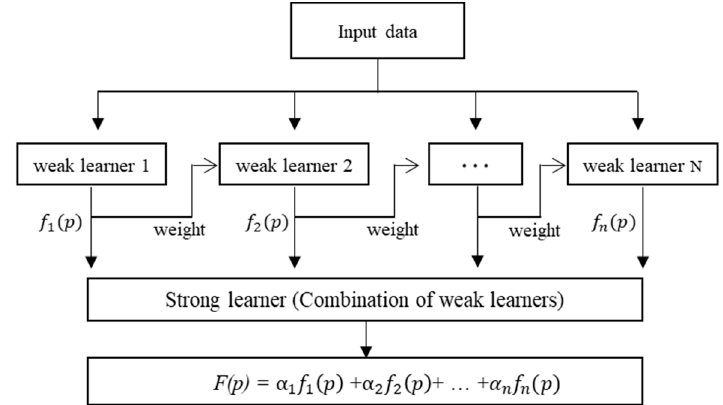
Figure 5. Procedure of ensemble from an input sample.